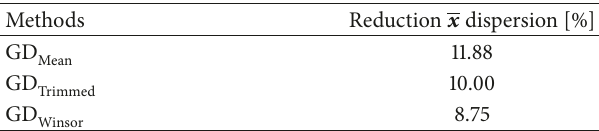
Table 25: Log-normal with 1000